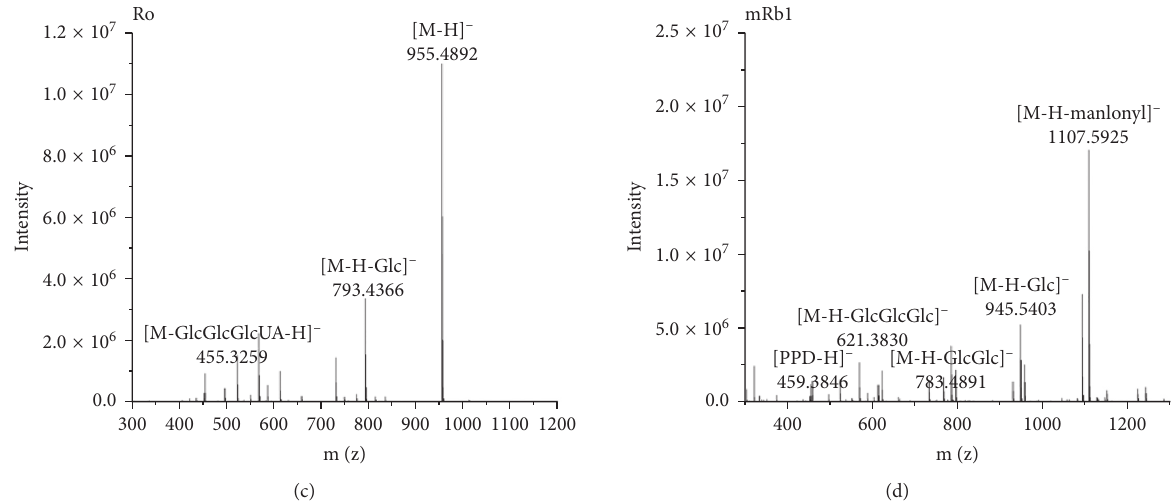
Figure 2: The tandem mass spectrum of ginsenosides in the negative ion mode: (a) Rg1; (b) Rb1; (c) Ro; (d) mRb1.